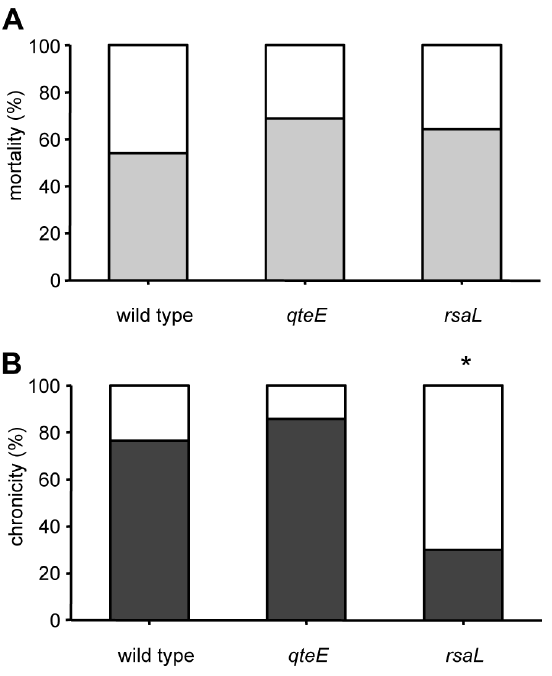
Figure 4. Effect of QS dysregulation caused by qteE and rsaL mutations on P.aeruginosa pathogenesis in mice. C57Bl/6 mice were infected with the indicated strains embedded in agar beads. (A) Mice mortality induced by bacteremia (light grey) and survival (white) were evaluated on challenged mice. (B) Clearance (white) and capacity to establish chronic airways infection (dark grey) were determined on surviving mice after 14 days from challenge. The results are averages of three independent experiments. Statistical significance is indicated by an asterisk comparing P. aeruginosa wild type versus qteE or rsaL strains ( p , 0.05).